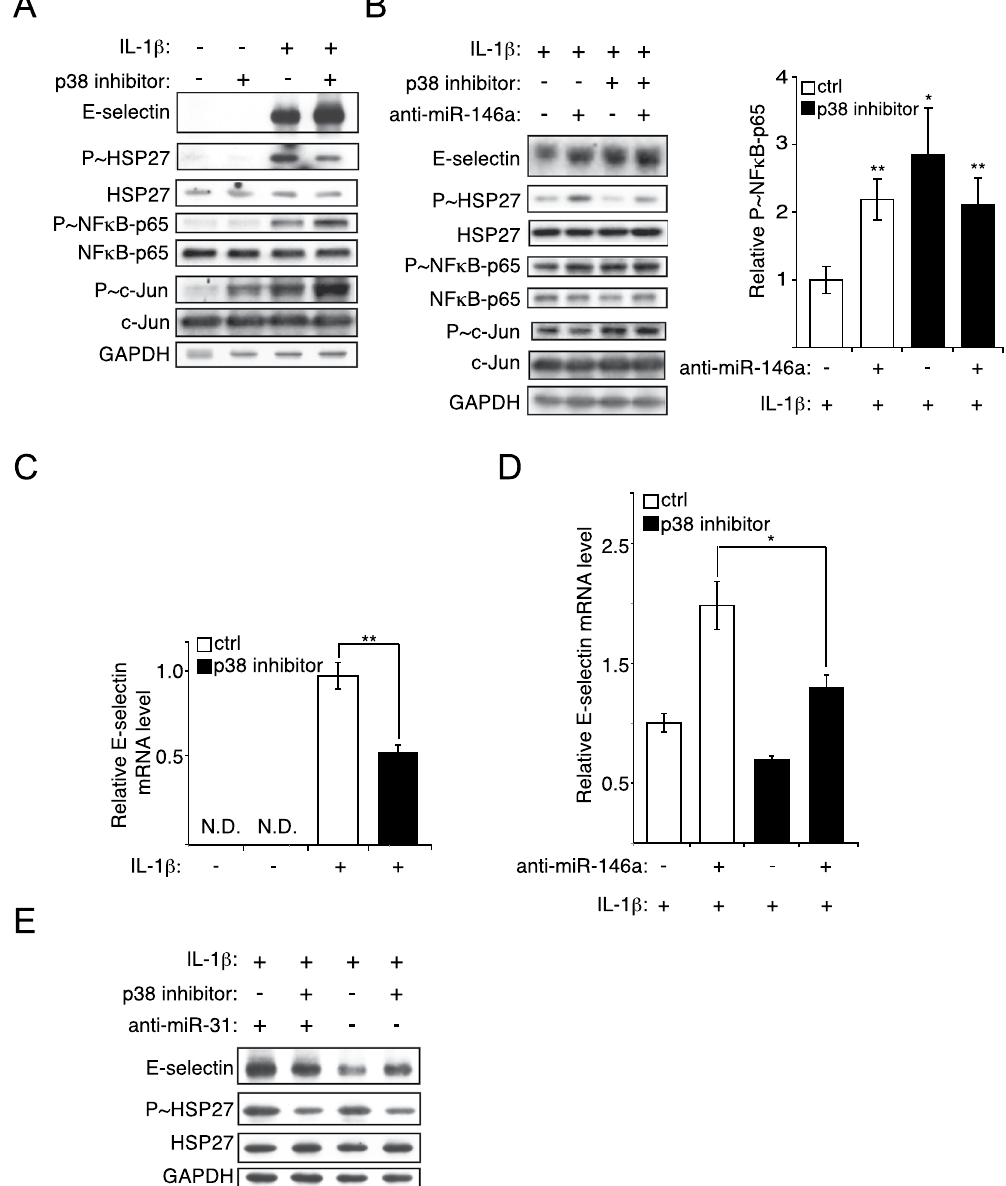
Figure 6. p38 MAP kinase downregulates the transcription and the translation of E-selectin by modulating miR-146a and miR-31. ( A ) Endothelial cells were pretreated with 10 μ M of p38 inhibitor SB203580, before being treated with IL-1 β (20ng/ml) for four hours. Western blotting monitored the expression of E-selectin and the activities of p38 (anti-phospho-HSP27 (S 82 )), NF- κ B (anti-phospho-p65 (S 536 )) and c-Jun (anti-phospho- c-Jun (S 63 )) signalling pathways. GAPDH was used as loading control. ( B ) Endothelial cells were transfected with 50 nM of miRNA inhibitors or control, before being pretreated with 10 μ M of p38 inhibitor SB203580, and treated with IL-1 β (20 ng/ml) for four hours. Analysis as in ( A ) The p -values are calculated comparing to the “antagomir ctrl/DMSO/IL-1 β ” group. ( C ) Endothelial cells were treated as in A . RT-qPCR monitored the level of E-selectin mRNA relative to GAPDH mRNA. ( D ) Endothelial cells were treated as in b., then analyzed as in ( C , E ) Endothelial cells were treated as in ( B ) Western blotting monitored the expression of E-selectin and the activities of p38 (anti-phospho-HSP27 (S 82 ) signalling pathway. GAPDH was used as loading control. The Western blots represent three independent experiments. The quantification are the mean values of three independent experiments, the error bars represent standard errors of three independent experiments, and the significance was analyzed using a Student’s t-test ( * p < 0.05; ** p < 0.01). N.D.: non